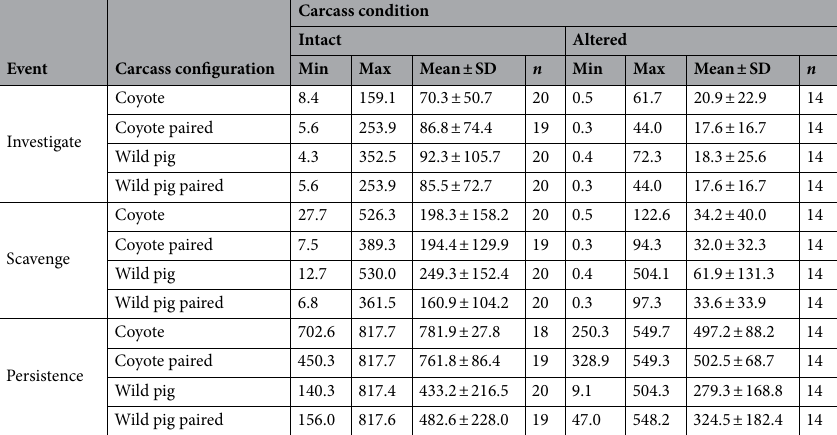
(Fig. 2). For intact trials, wild pig and paired wild pig carcasses had more similar scavenging communities than other carcass configurations. Intact coyote carcasses had different assemblages between coyote only and coyote carcasses paired with wild pigs, as raccoons ( Procyon lotor ) and great-horned owls ( Bubo virginianus ) only scav- enged unpaired coyote carcasses (Table S1). The correspondence analysis also revealed a greater diversity of avian scavengers associated with intact coyote carcass assemblages than intact wild pigs. Altered carcass configurations had distinct scavenger assemblages (Fig. 2b), with carnivore carrion being scavenged dissimilarly than omnivore carrion. Virginia opossum and wild pig were more associated with the scavenger assemblages of coyote carcass configurations, whereas the raccoon and coyote were more associated with wild pig carcass configurations. At intact trials, 12 vertebrate species were documented scavenging intact carcasses, whereas 7 species were documented scavenging altered carcasses (Tables S1 and S2). These numbers do not include non-sciurid rodent species, given smaller vertebrate species were not reliably detected at all carcasses. Excluding rodent scavenger diversity may have affected our results given many rodents are scavengers 10,14 , therefore future studies should incorporate more sensitive camera technology to more thoroughly capture the vertebrate scavenging community. Scavenging species richness varied from 1 to 5 species at intact carcasses and 0 to 4 species at altered carcasses. For intact trials, carcass mass did not influence scavenger richness ( P = 0.62; Table S5); however, scavenger spe- cies richness was greater for paired wild pig carcasses ( x = 3.21), the reference group, than for unpaired wild pig carcasses ( x = 2.15; P = 0.04). There were no other significant interactions between carcass configurations and scavenger richness for intact trials (coyote— x = 2.22; P = 0.07, paired coyote— x = 2.42; P = 0.15). Scavenger